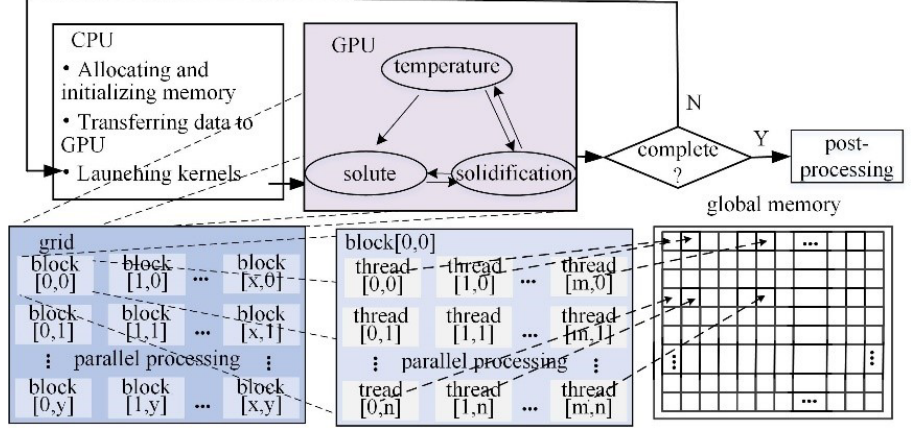
Figure 2. GPU-CA architecture.